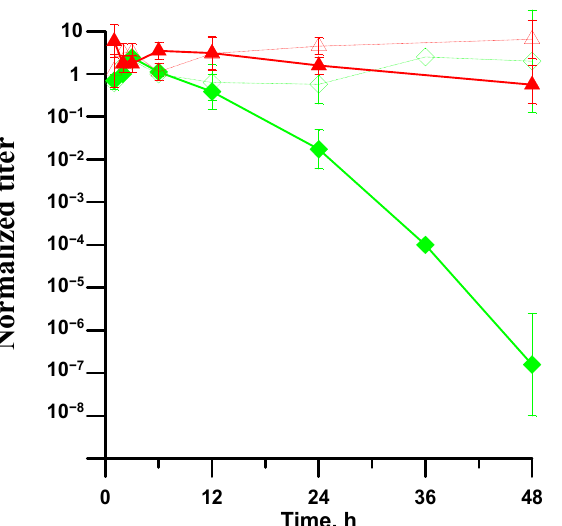
Figure 5. Time evolution of bacterial titer of K. pneumoniae (green diamonds) and P. Aeruginosa (red triangles) in the bacterial dispersion in contact with the immersed MA8 alloy sample with a superhydrophobic coating (full symbols). Empty symbols show the corresponding variation in the bacterial titer in the control dispersions without immersed samples. The normalized titer was calculated as a ratio of the titer in an assay taken at a given time to the initial titer in the dispersion.